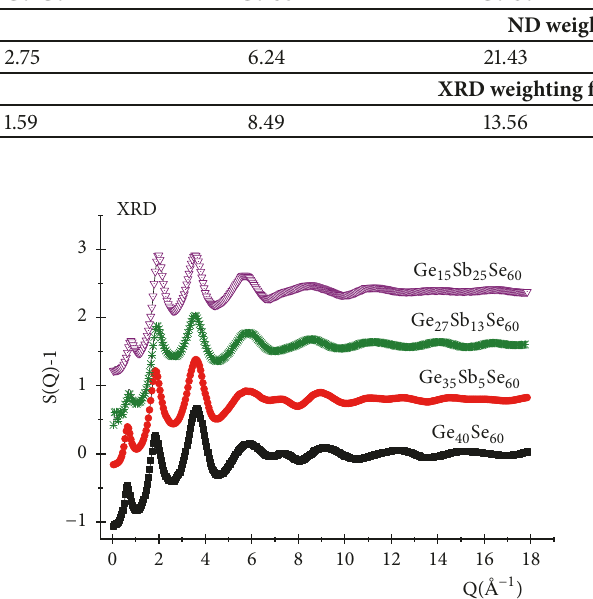
Figure 2: X-ray diffraction structure factor, S ( Q ), of the ternary Ge x Sb 40 Se 60 with composition of x=35, 27, 15 at.% and the binary - x Ge 40 Se 60 glasses is displayed: experimental data (colour marks) and RMC simulation (solid lines). For better clarity, the curves are shifted